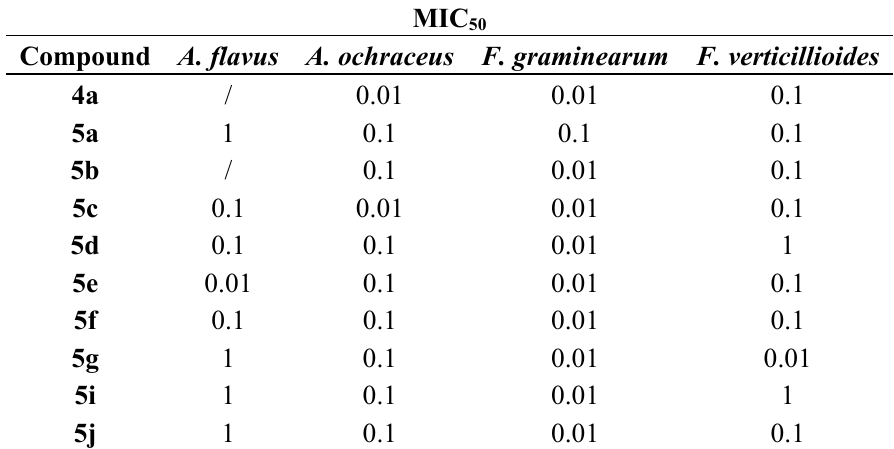
2. Minimal inhibitory concentration for 50% cell death for the tested thiadiazine derivatives.